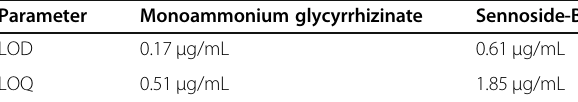
Table 6 LOD and LOQ data of developed method